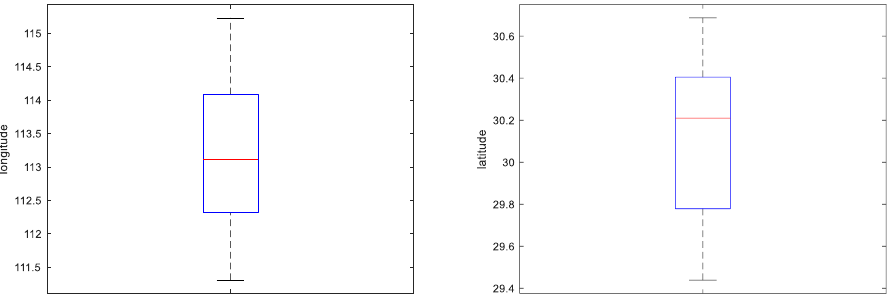
Figure 7. Distribution of longitude and latitude.